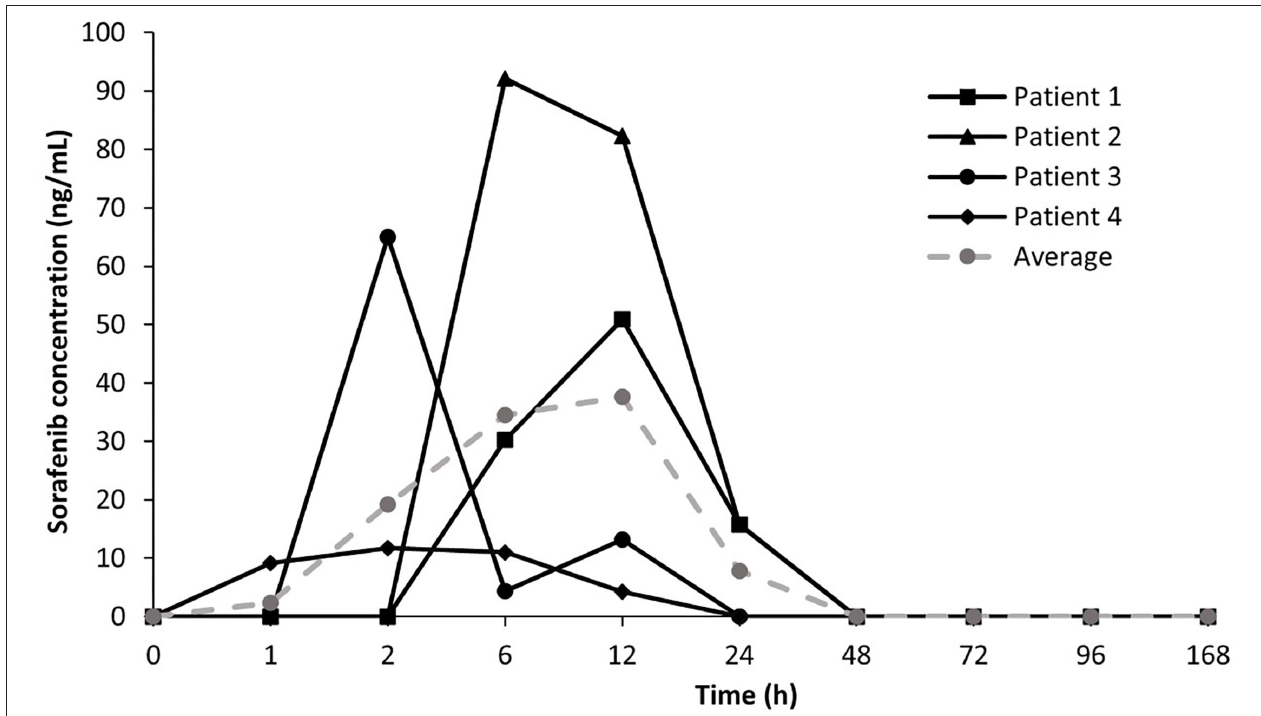
FIGURE 1 | Time-course of sorafenib serum concentrations in tumor-bearing dogs. Mean and average sorafenib serum concentration – time profiles for four patients treated with oral sorafenib at 3